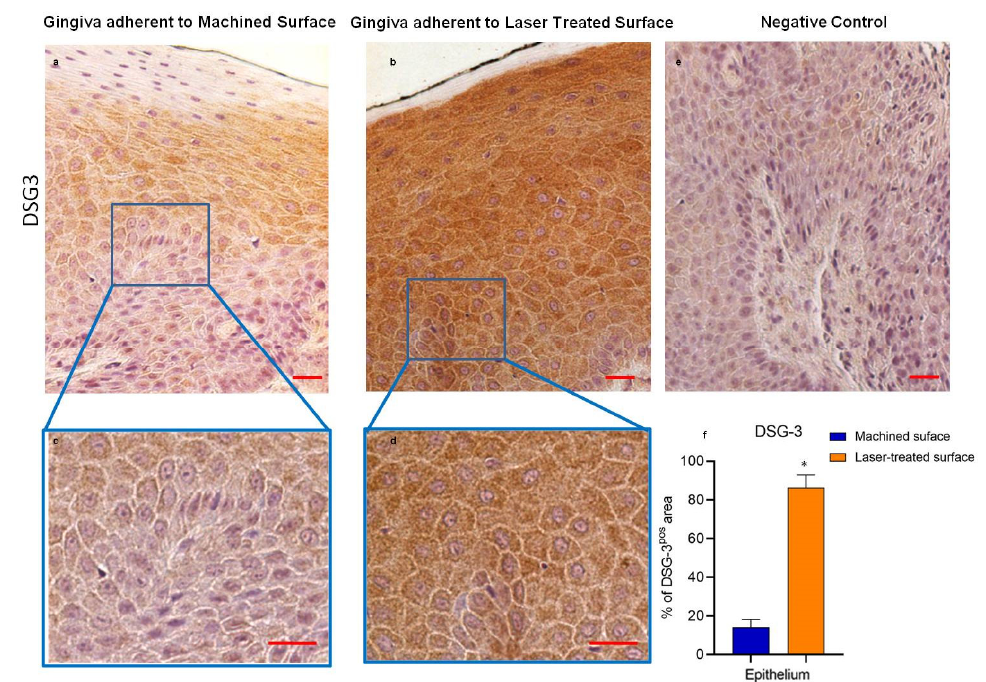
Figure 6. Immunostaining against DSG-3 of the region of gingiva adherent to the machined surface ( a and c ) or the laser-treated surface ( b and d ), as indicated. ( e ) represents the negative control. Images are representative of 15 different experiments. Scale bar: 10 µm. ( f ) Bar graphs show the percentage of DSG-3 immunostaining positive areas in the epithelial layers, as indicated. Values are expressed as mean ±SD of five determinations in randomly chosen sections for each specimen. * indicates values statistically different ( p <0.001) between the region of the gingiva adherent to the laser-treated or to machined surfaces, as indicated. Table 1 summarized the expression of inflammatory markers and cytokeratin expression in soft tissues facing machined or nanopored laser-treated healing abutment. Table 1. Evaluation of inflammatory markers and cytokeratins expression in soft tissues facing machined or nanopored laser-treated healing abutment.